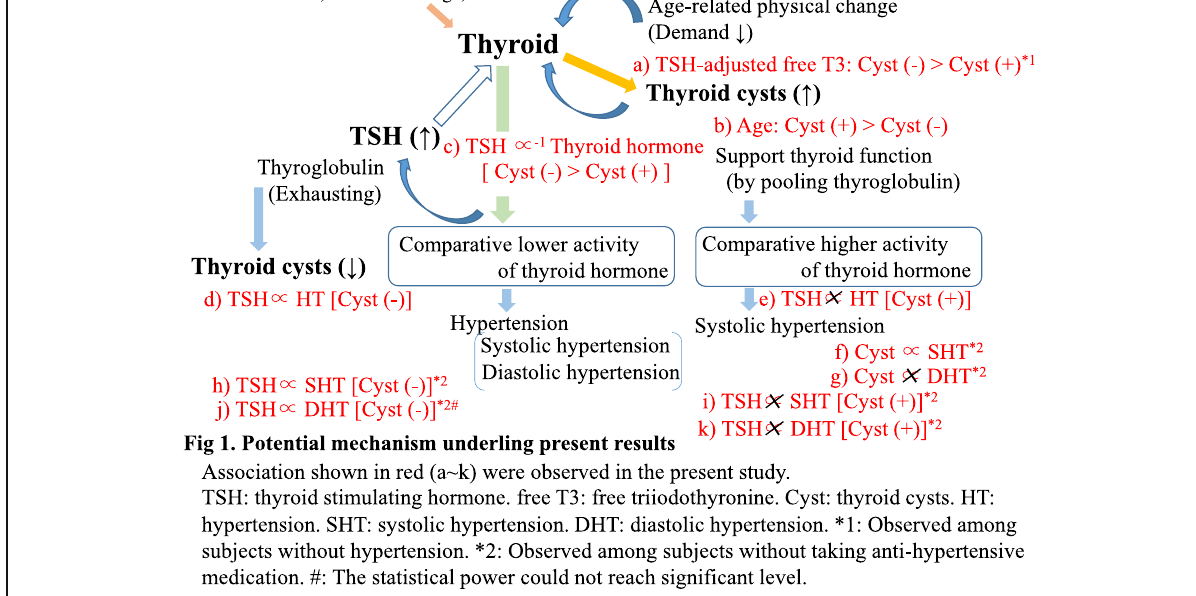
Fig. 1 Potential mechanism underling present